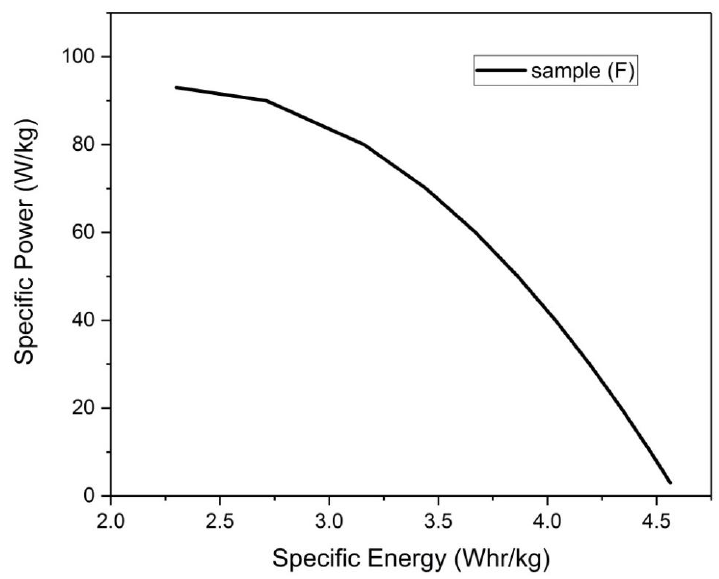
Figure 24. Ragone plot for sample (F).